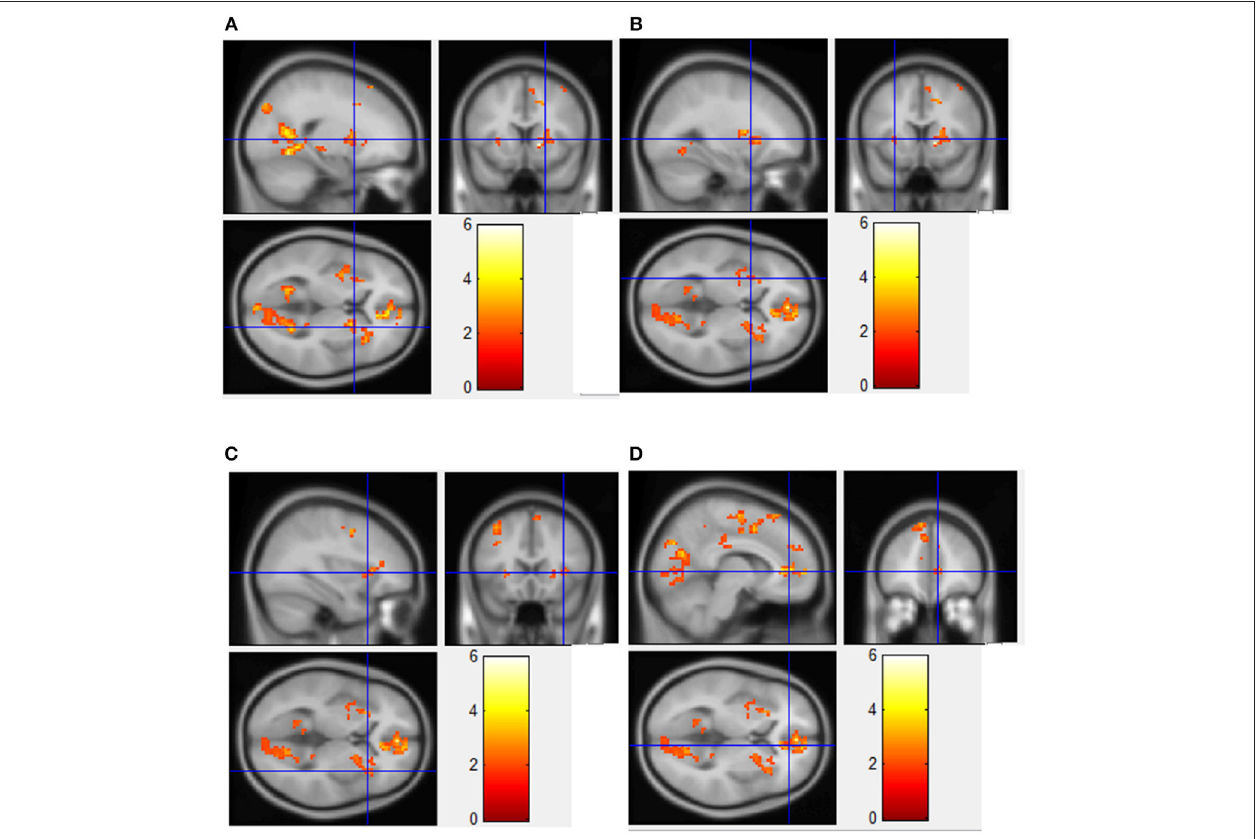
FIGURE 3 | Regions showing significantly greater fMRI activation during viewing of HF/HCCHO images compared to non-food control images. Implicated regions (shown with blue cross-hairs) include the right putamen (A) ; left putamen (B) ; right insula (C) ; anterior cingulate cortex (D) .